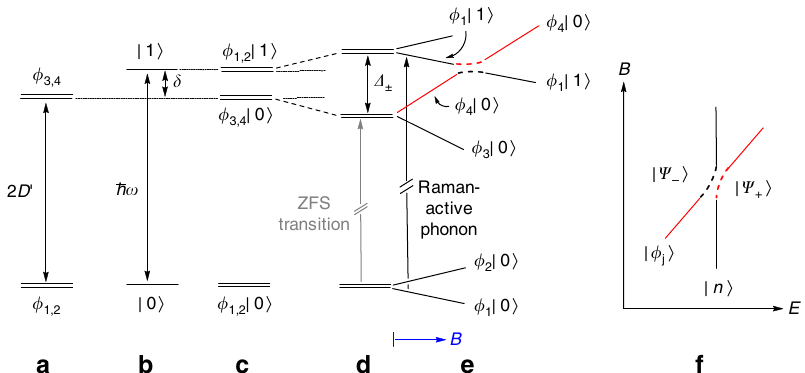
Fig. 3 Schematic view of the spin – phonon coupling. a Zero- fi eld splitting 2 D' of the magnetic/spin quartet ground state (with eigenfunctions in Fig. 1c when no fi eld is applied; off-axis fi eld induces additional M S mixing). b Vibrational states of a selected phonon with eigenfunctions |0 〉 and |1 〉 and a small energy separation δ above the excited KD ϕ 3,4 . c Spin – phonon product states with product functions ϕ i | n 〉 still without vibronic coupling. d Vibronic coupling with coupling constant Λ , leading to an energy shift and splitting: Δ ± = ( δ 2 + Λ 2 ) 1/2 . The ZFS transition (in gray color) is vanishingly weak in Raman spectra because it is only magnetic-dipole-allowed. e Zeeman splitting of vibronic states in a fi eld B and avoided crossing from the coupling between the ϕ 4 |0 〉 and ϕ 〉 states. Note the states ϕ 〉 and ϕ 〉 have pairwise identical slopes, whereas ϕ 〉 and ϕ 〉 have different slopes. The net transition from the 1 |1 1,2 |0 1,2 |1 1,2 |0 3,4 |0 lowest level ϕ 1 |0 〉 to ϕ 1 |1 〉 is in essence a phonon excitation and thus Raman-allowed (black arrow), and it is fi eld-independent. When ϕ 4 |0 〉 , the upper magnetic level of the excited electronic KD, approaches ϕ 1 |1 〉 , additional coupling occurs, leading to a fi eld-dependent transition. The ZFS transitions in ( d ) are vanishingly weak in Raman spectra, because they are only magnetic-dipole-allowed. The same holds for the ϕ 1 |0 〉 → ϕ 3 |0 〉 , ϕ 1 |0 〉 → ϕ 4 |0 〉 , and ϕ 1 |0 〉 → ϕ 〉 transitions, which are not marked in ( e ). (Transitions from the fi rst excited level, ϕ 〉 , are neglected because of vanishing thermal population 2 |1 2 |0